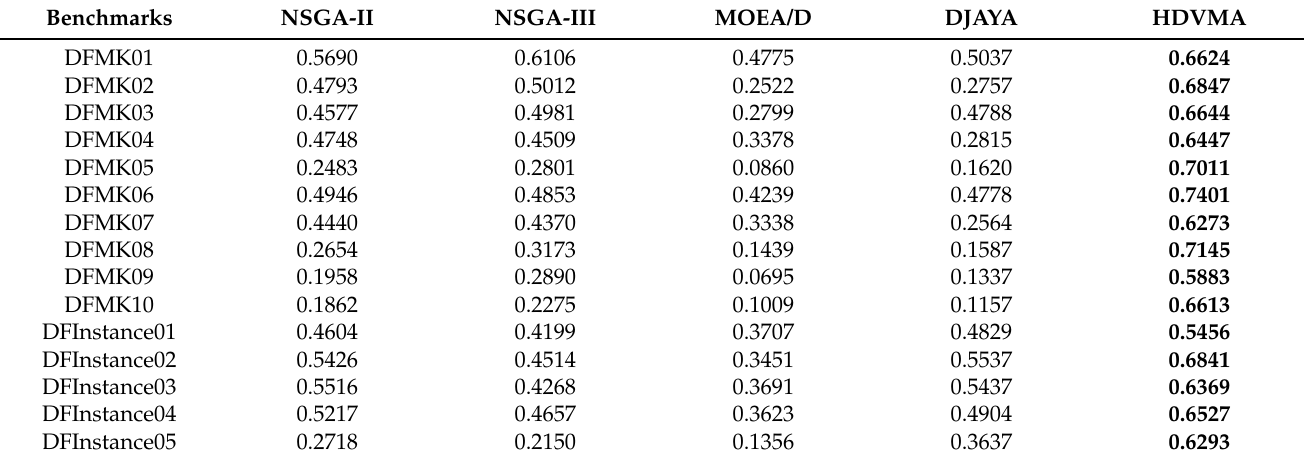
Table 7. HV value comparison.